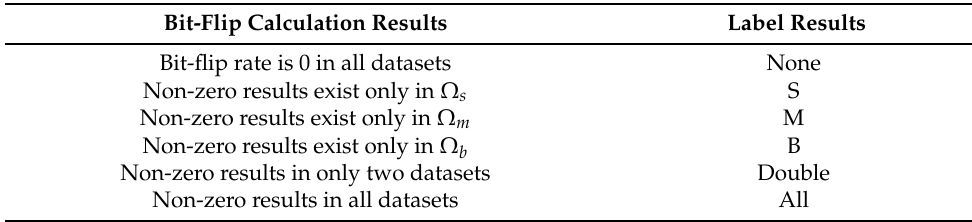
Table 2. Mapping of bit flip rate results to labels.